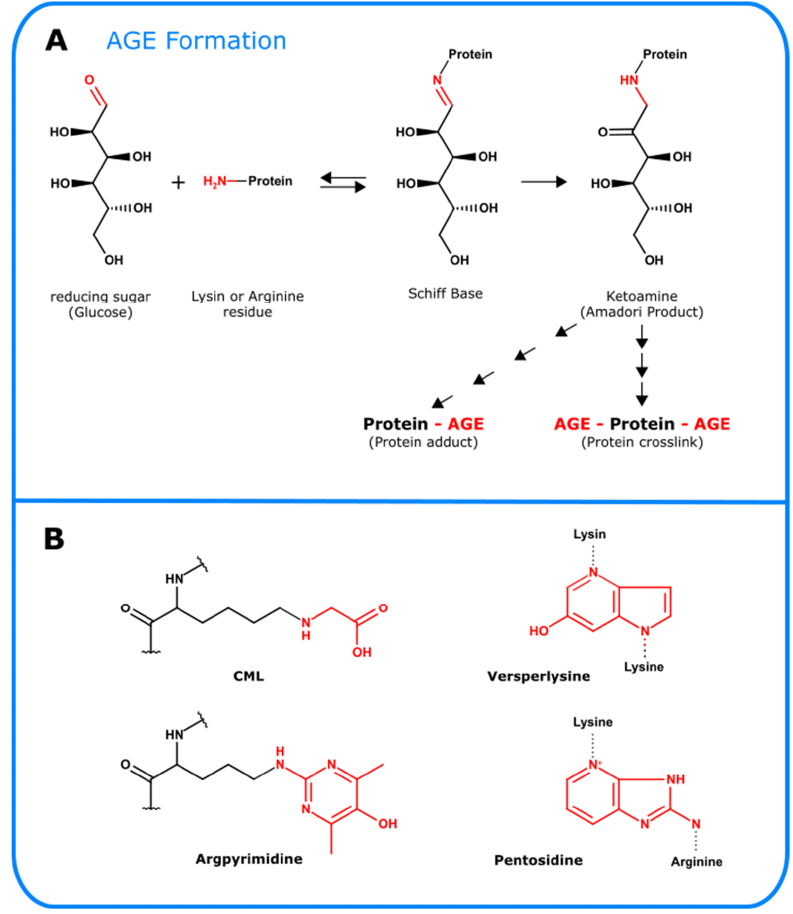
Figure 10. Advanced glycation end products (AGE). ( A ) Simplified overview of AGE formation. ( B ) Overview and chemical structures of common AGEs such as ε-N-carboxymethyllysine (CML), Versperlysine, Argpyrimidine, and Pentosidine.